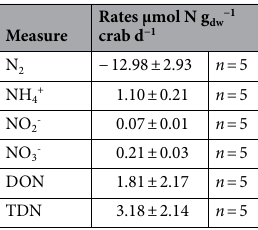
Table 2. Nitrogen fluxes associated with fiddler crab individuals incubated in microcosms. Average and standard errors are given. Total dissolved nitrogen was calculated as sum of NH 4 + , NO 2 - , NO 3 - and DON.